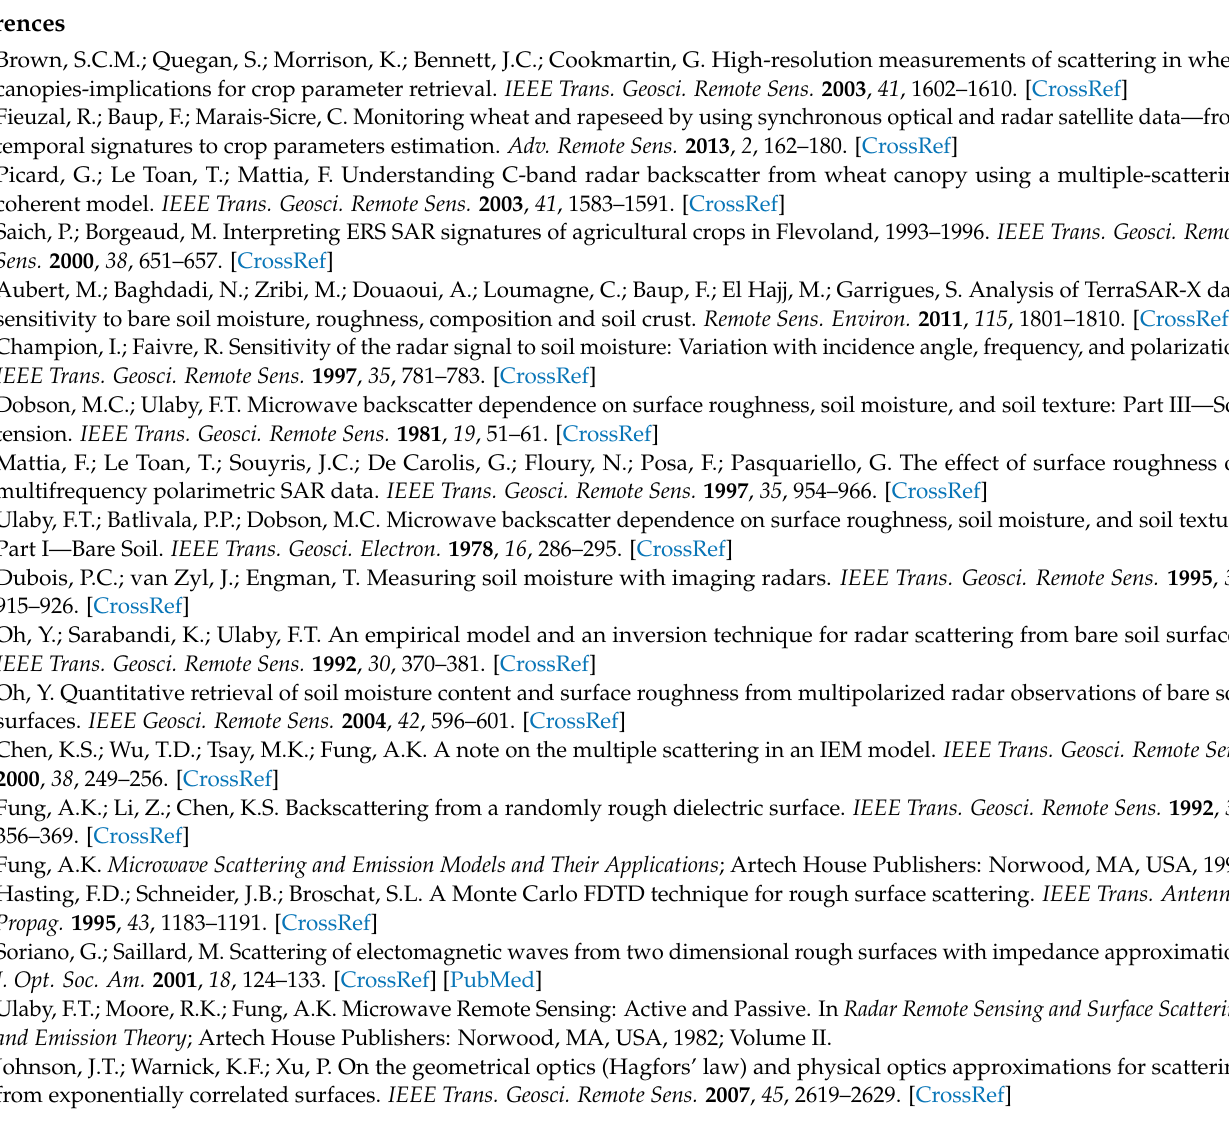
where Freq is the considered band, Pol is the polarization state, X 1 is TSM, X 2 is the fraction of clay, X 3 and X 4 are the standard deviation of roughness heights and the autocorrelation length, both collected in the direction parallel to the tillage orientation regarding the surface roughness, and P is the corresponding